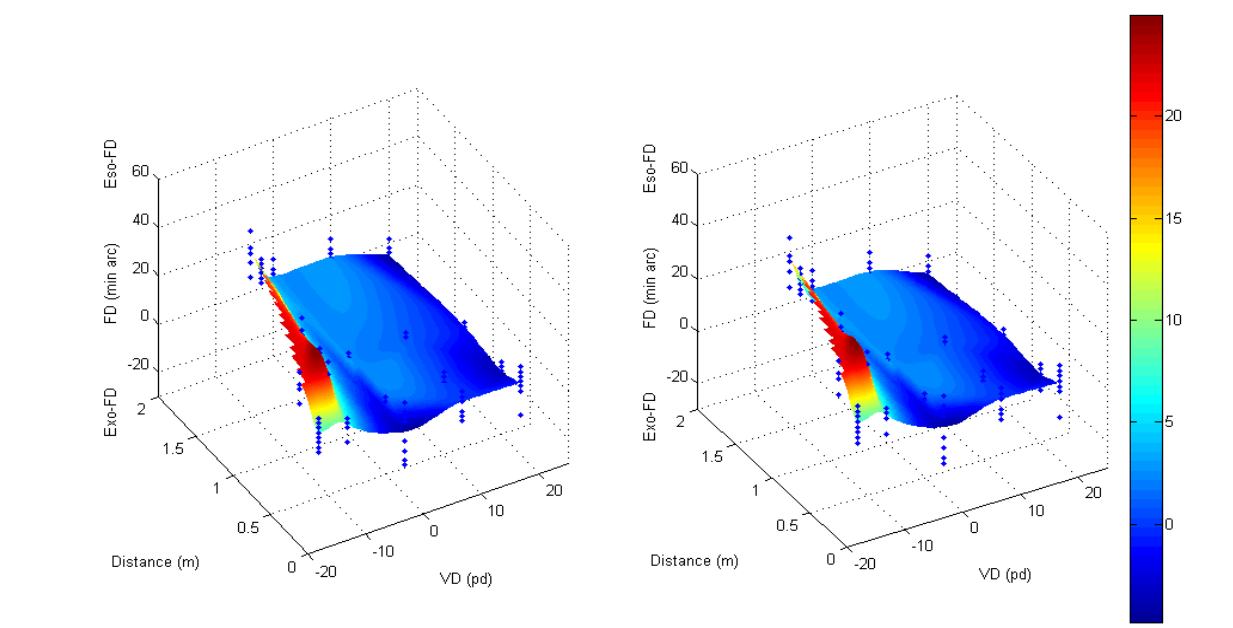
Figure 6 . Stereo-pair plot of the surface of forced vergence disparity for Subject 1. Warmer colours (red and orange) represent larger eso-FD with BI prism or forced divergence at the various distances concerned. The blue dots are the raw measurements to which this best-fit surface has been fitted. The colour bar on the right side represents fixation disparity in min arc